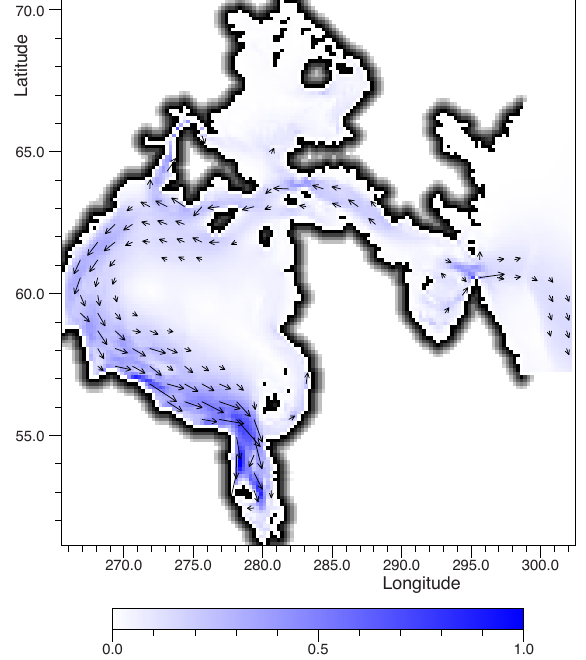
Figure 9. Energy flux vectors for resonance F. The flux is nor- malised so that its maximum value is one.